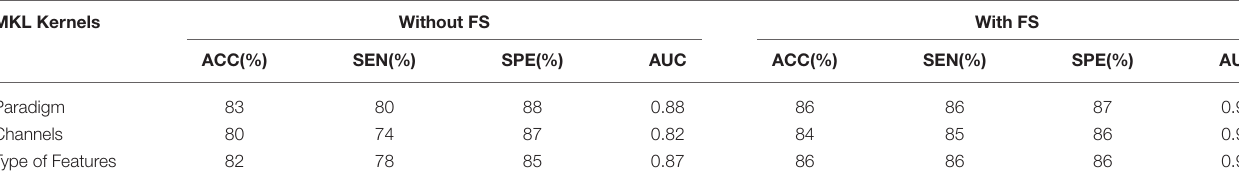
TABLE 4 | Performance of MKL algorithm with and without feature selection. MKL